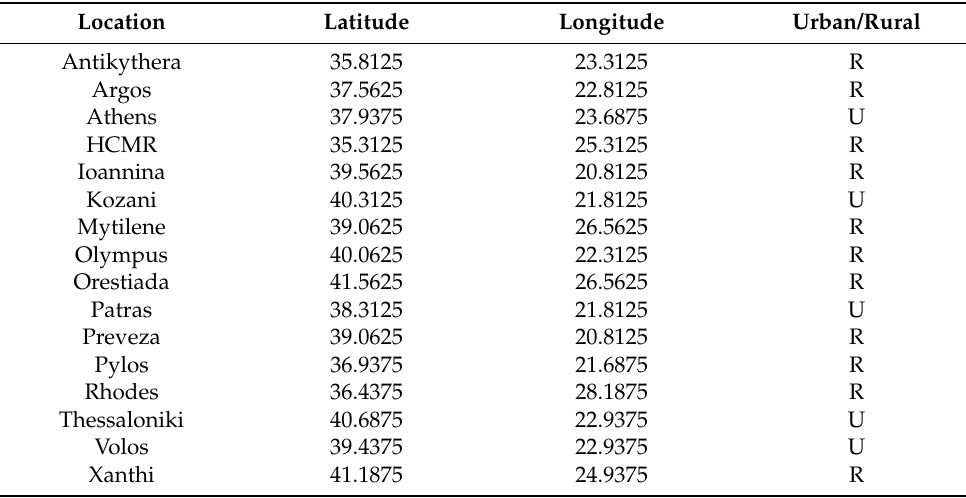
Table 1. Names of the 16 locations in Greece examined in this work along with the central coordinates of the grid cells they cover and the indication urban or